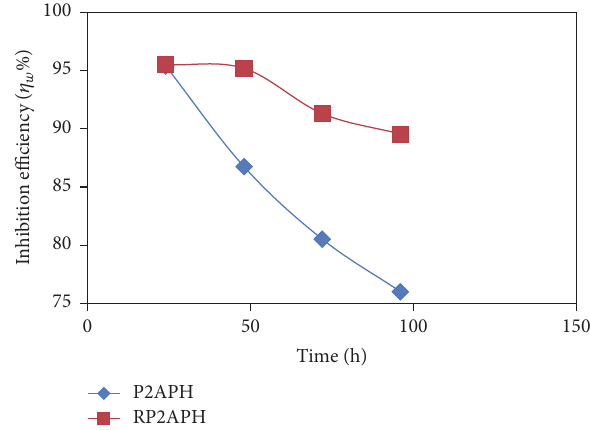
Figure 2: Variation of corrosion inhibition efficiencies ( 𝜂 𝑤 %)